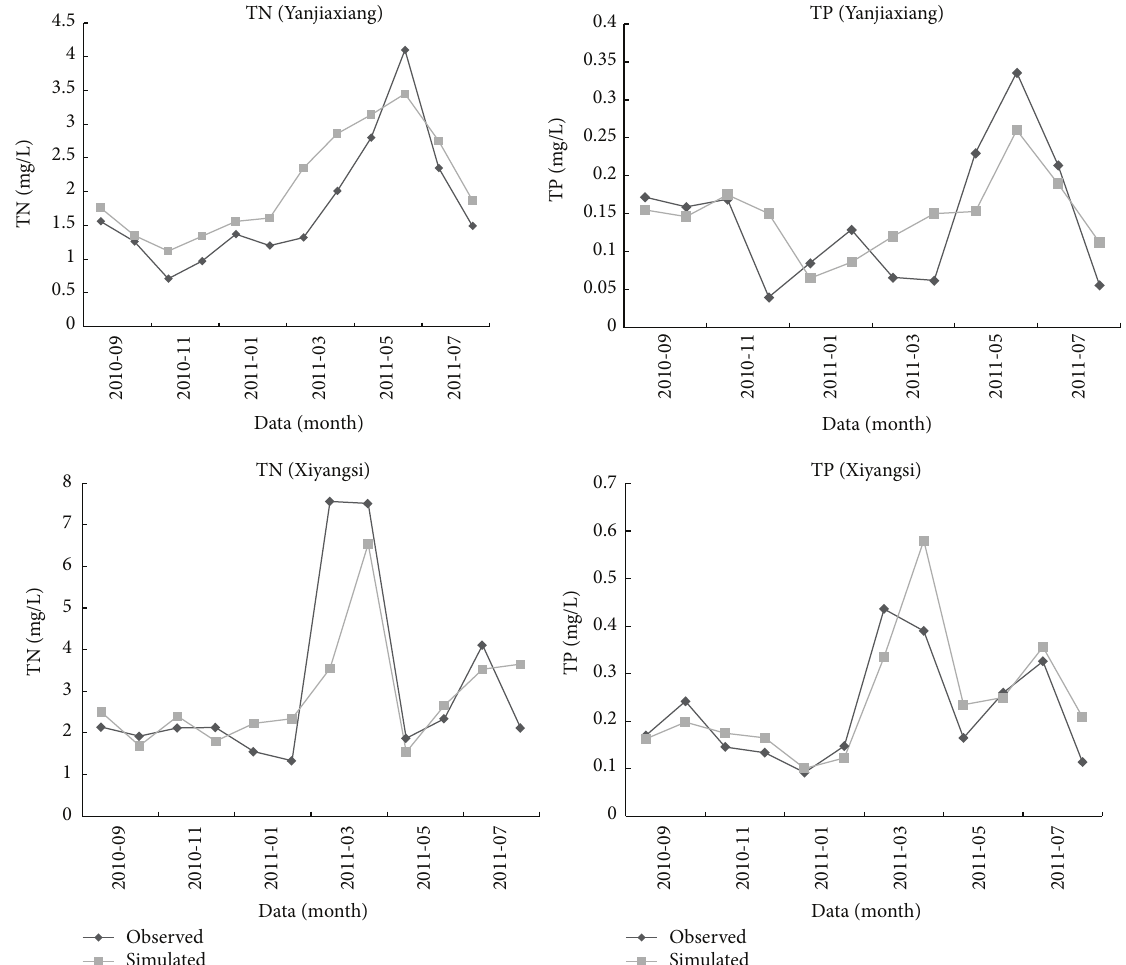
Figure 6: Observed and simulated TN and TP at Yanjiaxiang or Xiyangsi (monthly calibration period).